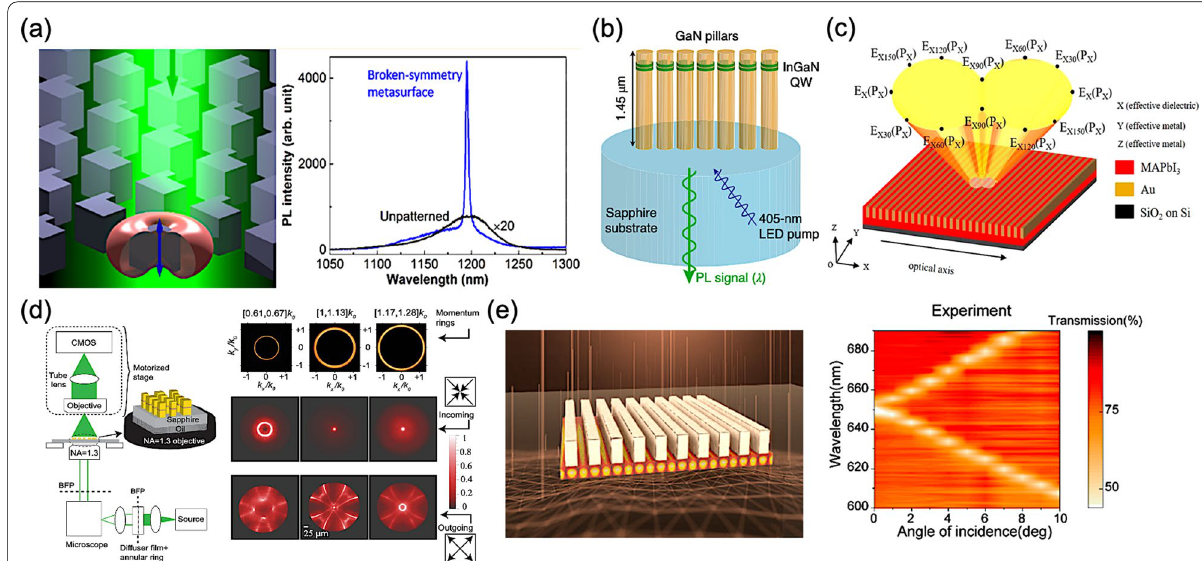
Fig. 12 Light‑emitting metasurfaces a Modal structure of symmetric and symmetry broken semiconductor metasurfaces [47], b Unidirectional luminescence from the InGaN/GaN quantum‑well metasurface [48], c Active perovskite hyperbolic metasurface with deep‑subwavelength alternating layers [49], d Light‑emitting metalenses and meta‑axicons for focusing and beaming of spontaneous emission [50], and e Enhanced multiphoton processes in perovskite metasurfaces